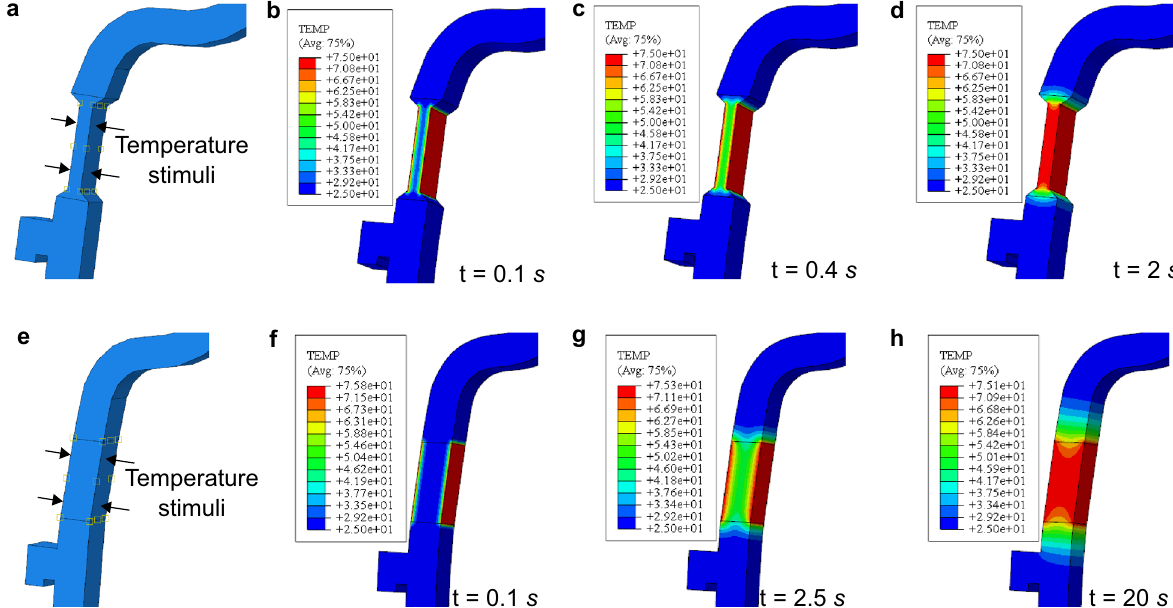
Figure 2. FEM heat transfer analysis in the hinges of the redesigned visor frame ( a – d ) and normal visor frame ( e – h ) for a temperature stimulus of 75 ◦ C. ( a , d ) The applied temperature stimulus area on the two visor frames respectively. ( b – d ) and ( f – h ) The temperature distribution of the visor frame at different time stamps. The temperature values in the plots are with units: degree Celsius ( ◦